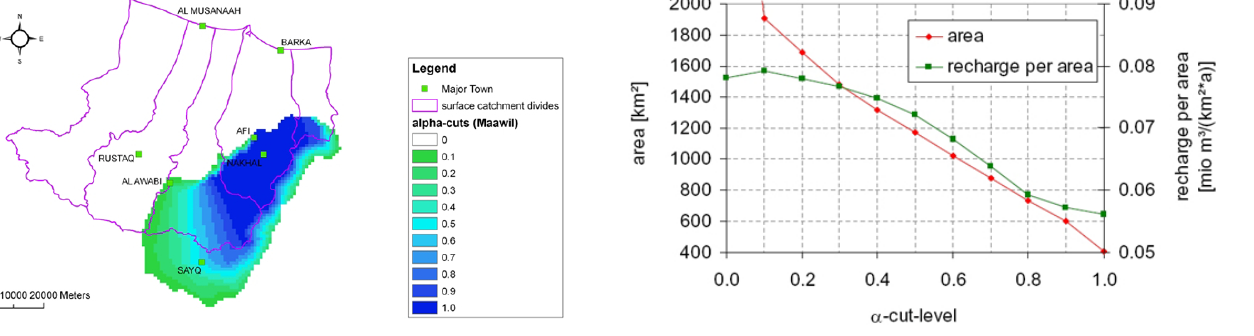
Fig. 9. Results (extent and recharge per area) for the Maawil plume.